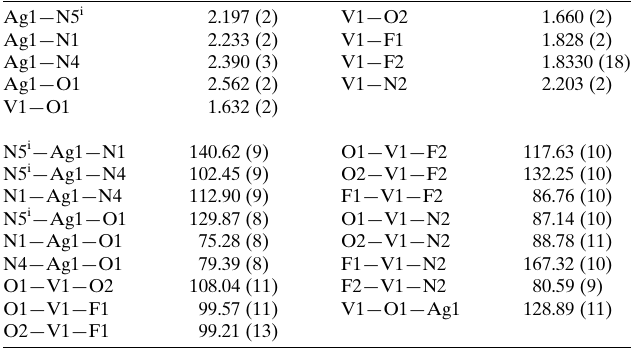
Table 1 Selected geometric parameters (A˚ , (cid:5) ).